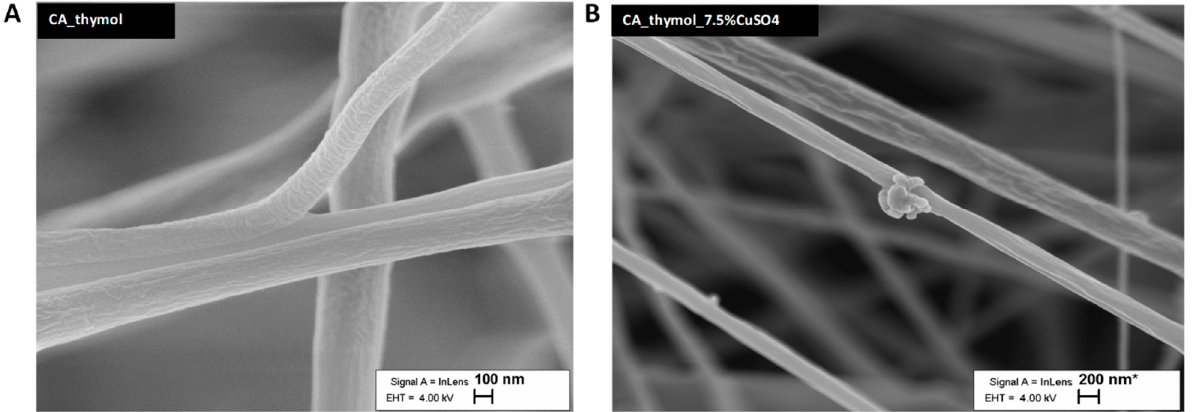
Figure 2. Morphological characteristics by SEM imaging for electrospun CA filter mats comprising thymol ( A ) and CuSO 4 ( B ) as additives, showing the texture change on the surface. thymol ( A ) and CuSO 4 ( B ) as additives, showing the texture change on the